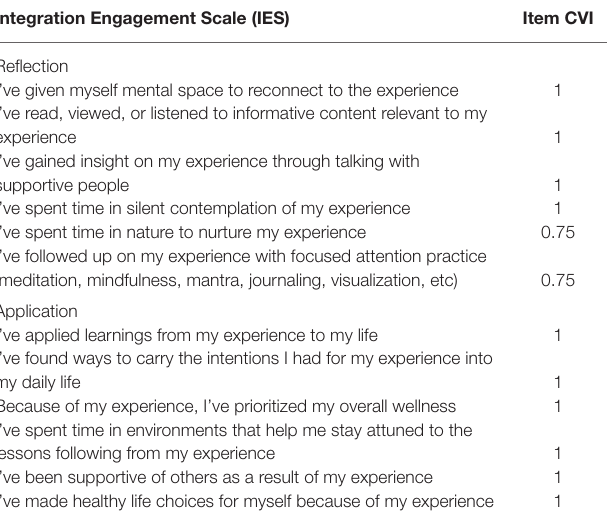
TABLE 2 | Integration engagement scale CVI results for final scale items.